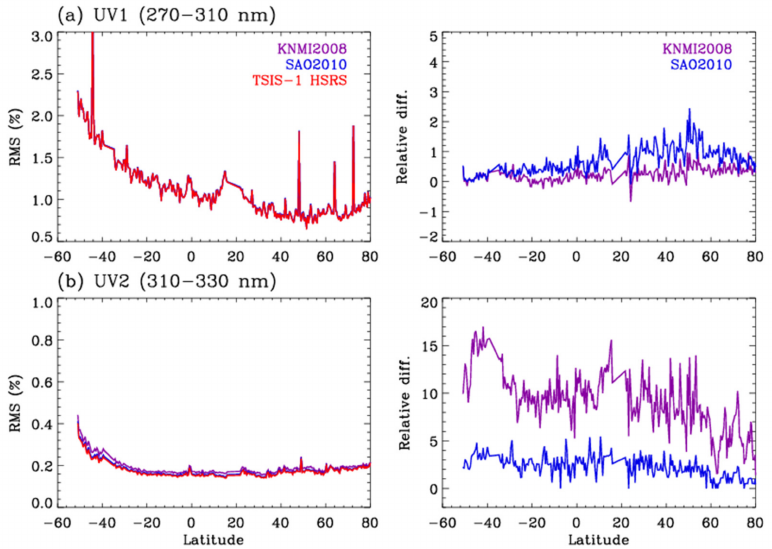
Figure 3. Impact of using different solar reference datasets on the RMS (%) of the spectral fitting residuals resulting from an orbit of retrieval at cross-track position 15 (nadir) on 1 July 2006 (orbit number: 10427). In the left panel, the fitting RMS values are plotted over the ( a ) UV1 and ( b ) UV2 ranges, respectively, as a function of the latitude with their differences relative to the TSIS-1 HSRS in the right